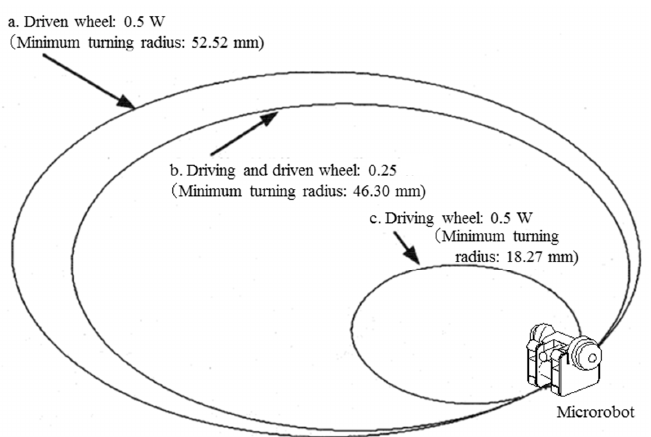
Figure 9. Trajectories (distribution of the magnetic attraction to driving wheels and driven wheels). a : Each driven wheel had a magnetic attraction of 0.5 W, and the driving wheels had no magnetic attraction. b : Each driven wheel and each driving wheel had a magnetic attraction of 0.25 W. c : Each driving wheel had a magnetic attraction of 0.5 W, and the driven wheels had no magnetic attraction.